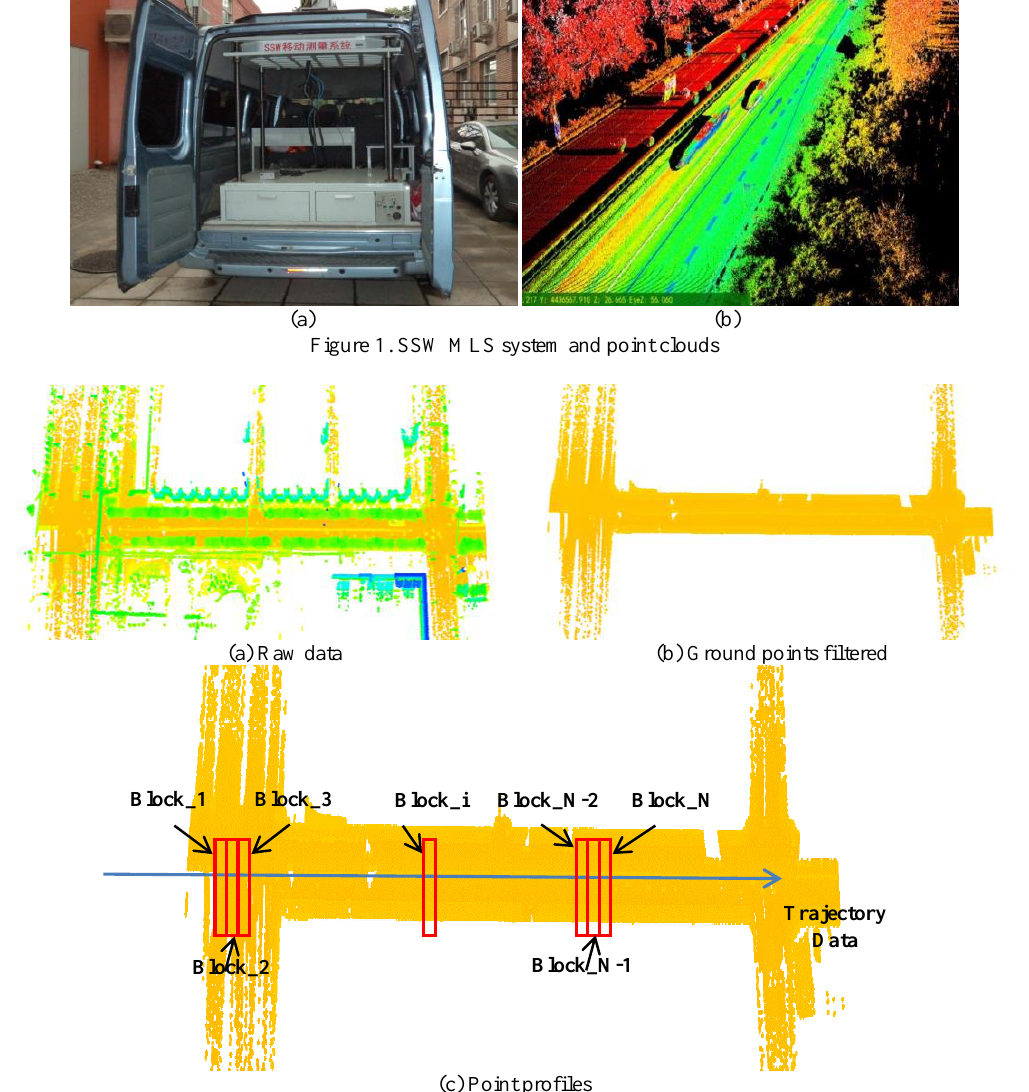
Figure 3. Extracting results of ground points based on 8-neighbor elevation filtering